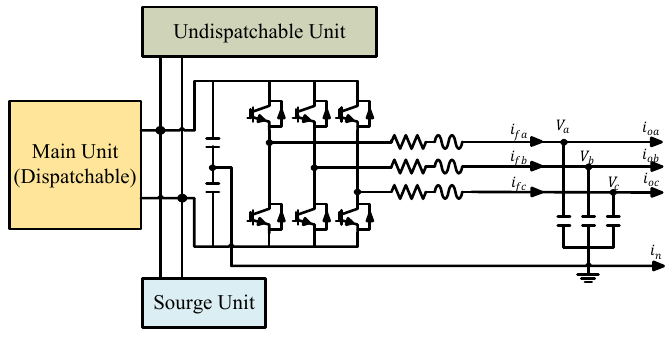
Figure 2. Three-phase four-wired inverter.